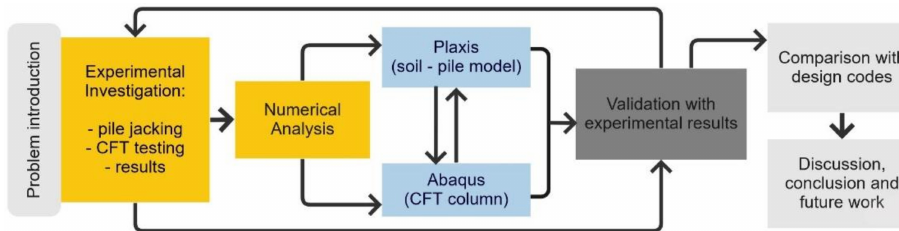
Figure 1. Schematic diagram of the paper flow.